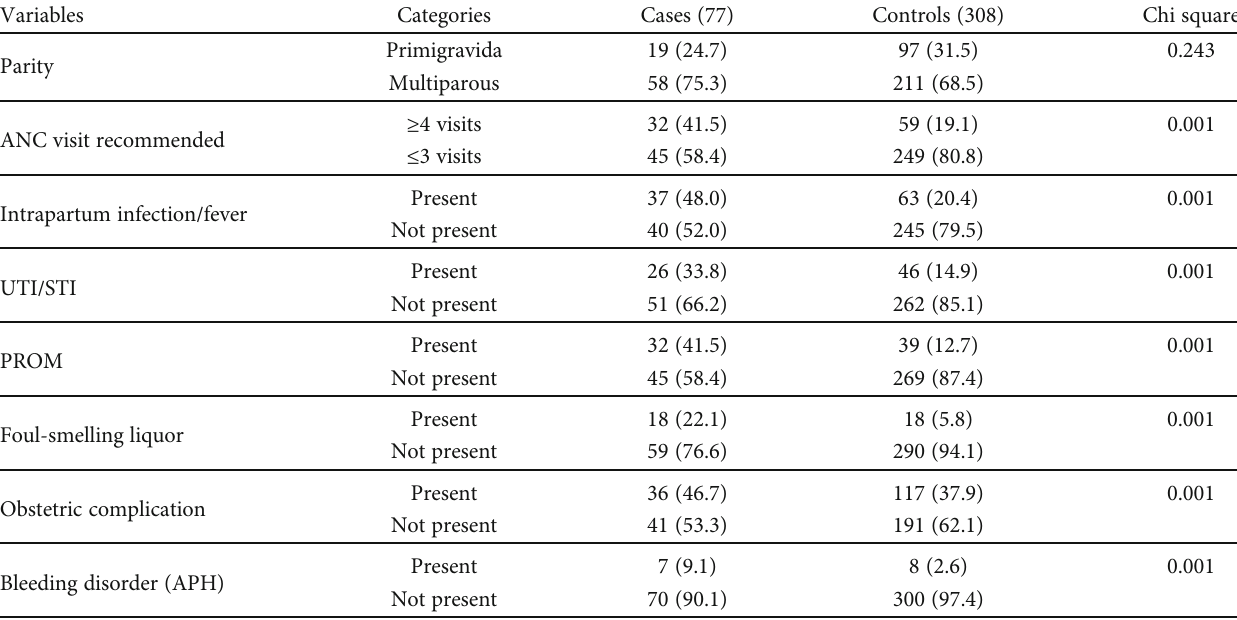
Table 2: Maternal obstetric factors of neonatal sepsis among neonates at SCGH and WSUTRH, Wolaita Sodo town, 2019. Variables